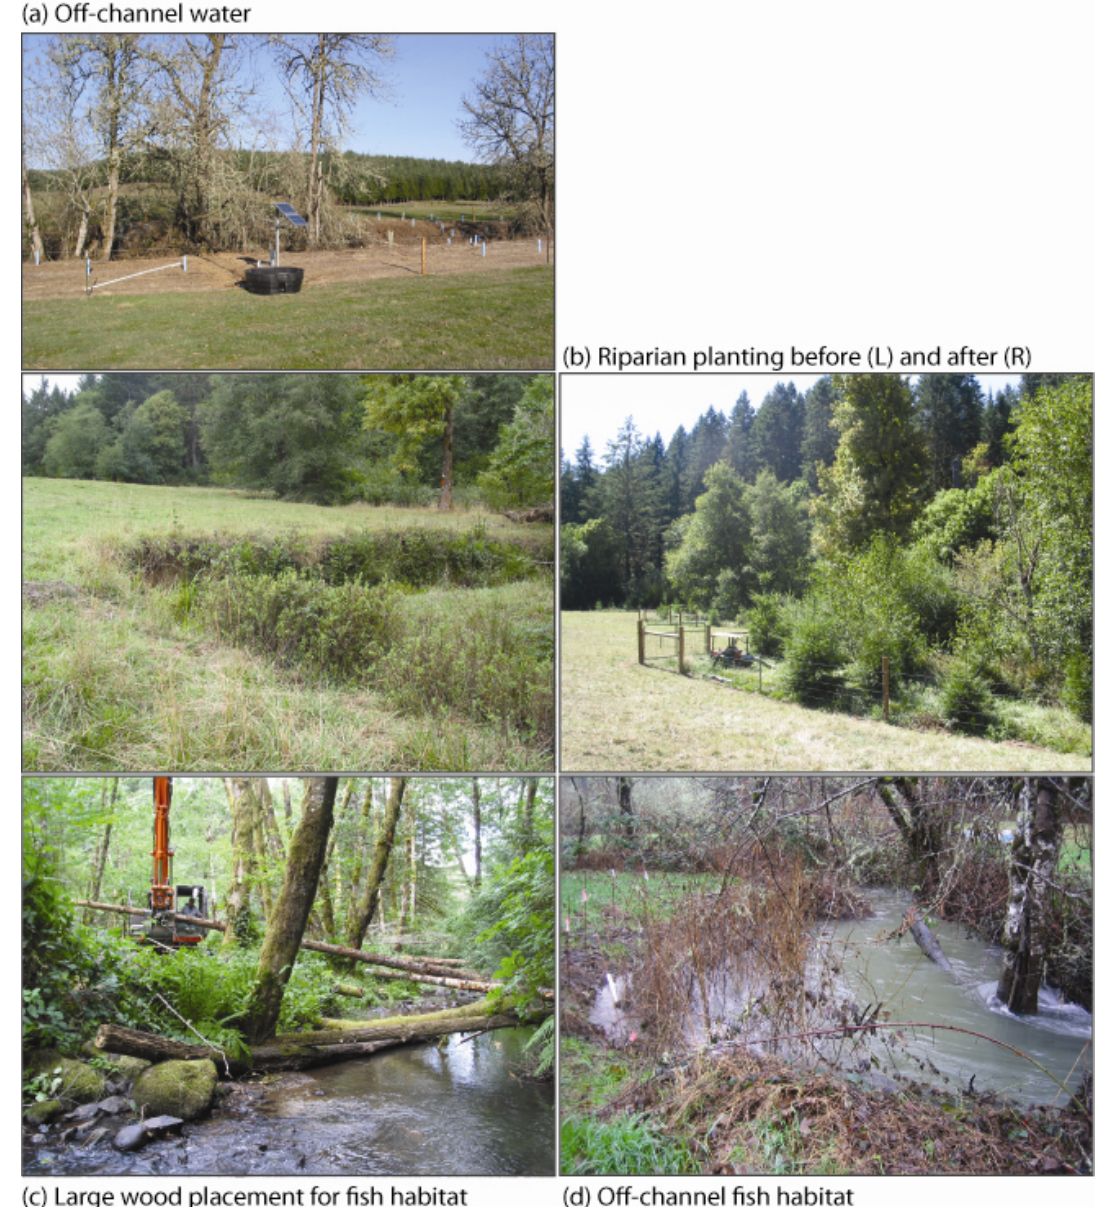
Fig. 7. Ferguson Creek coordinated multiple habitat enhancement projects. On Ferguson Creek, multiple habitat enhancement projects were identified through the subwatershed enhancement program. This project targeted sites with high ecological value coupled with committed landowners. Two culverts were removed, making available several kilometers of high-quality cutthroat trout habitat. Livestock exclusions with off channel watering systems (a), riparian plantings (b), instream habitat enhancement through the addition of large wood (c), and multiple techniques were used to increase floodplain capacity including stream habitats that flood off channel terraces